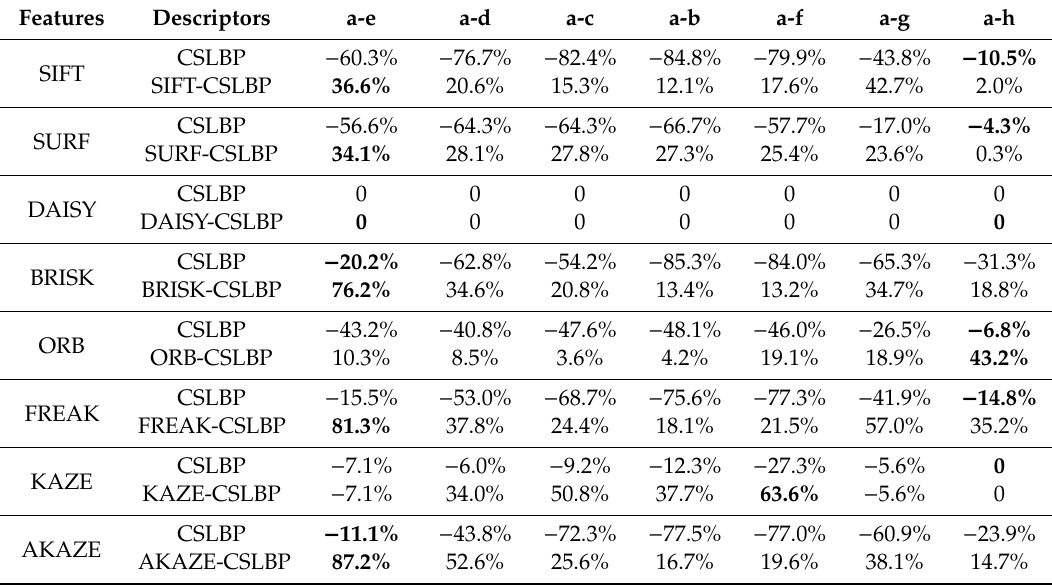
Table 6. The improved values of precision for the CSLBP and the combined descriptors compared to the original descriptors of Boat